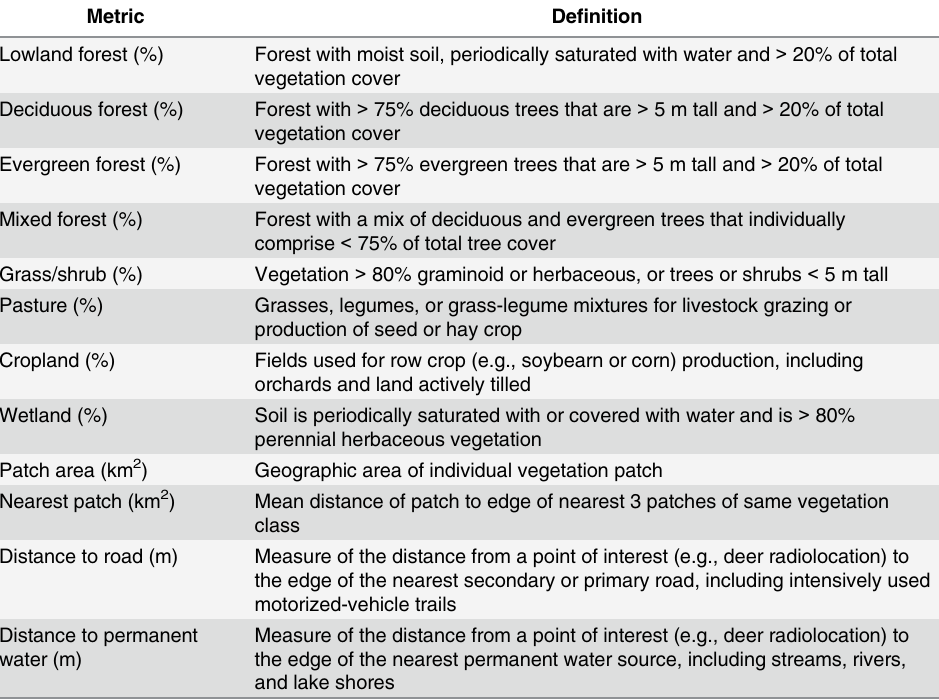
Table 2. Metrics used to assess resource use of neonatal white-tailed deer ( (cid:1) 14 weeks of age), south- central Upper Peninsula of Michigan, USA, 2009 – 2011.